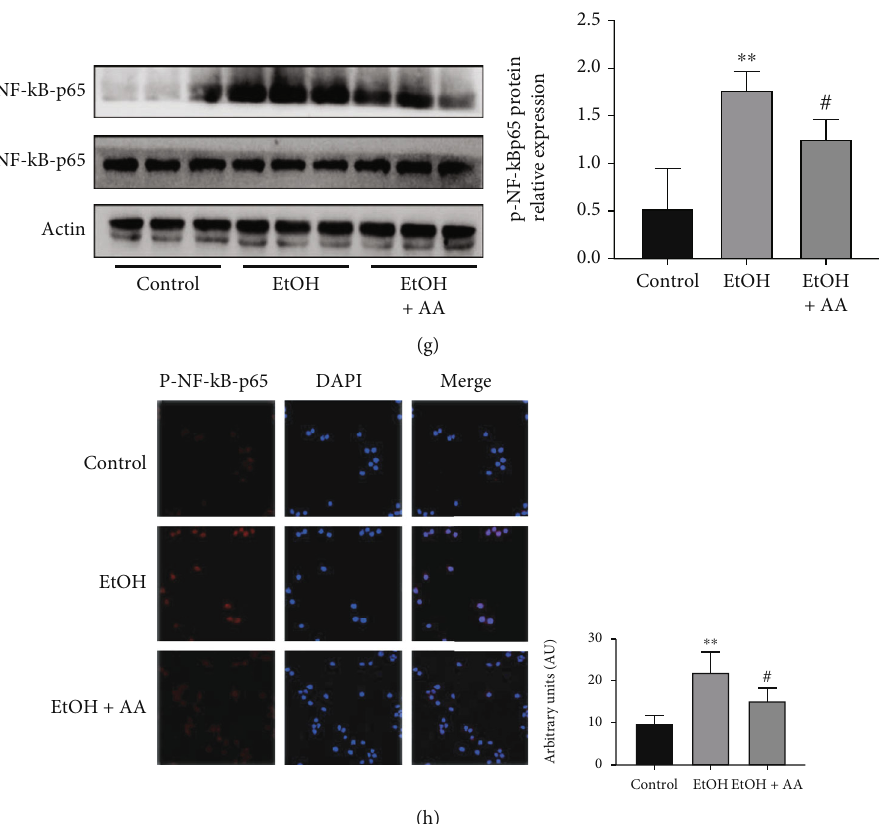
Figure 8: Asiatic acid may inhibit alcohol-induced in fl ammation by regulating NF- κ B pathway in the RAW264.7 cells. (a) Relative cell viability of RAW264.7 cells. (b) Relative mRNA expression of IL-1 β , IL-6, and TNF- α in the RAW264.7 cells. (c – e) Levels of f IL-1 β , IL- 6, and TNF- α in the supernatant of RAW 264.7 cells. (f) Relative protein expression of IL-1 β , IL-6, and TNF- α in the RAW264.7 cells. (g) Relative protein expression of P-NF- κ B-p65 in the RAW264.7 cells. (h) Representative immuno fl uorescence images of P-NF- κ B-p65 (red) ( × 200) in the control and EtOH groups are presented ( scalebar = 20 μ m ). ∗ P < 0 : 05, ∗∗ P < 0 : 01, and ∗∗∗ P < 0 : 001 compared with the Control group. # P < 0 : 05, ## P < 0 : 01, and ### P < 0 : 001 compared with the EtOH group. The data represent the mean ± S : D : of at least three independent